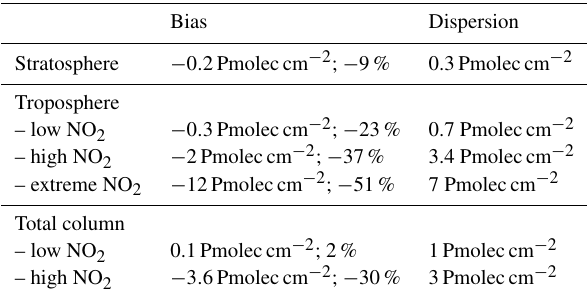
Table 4. Cross-network summary of the validation results: bias (me- dian) and dispersion (IP68/2) of the difference with respect to the ground-based correlative measurements (median value over the sta-